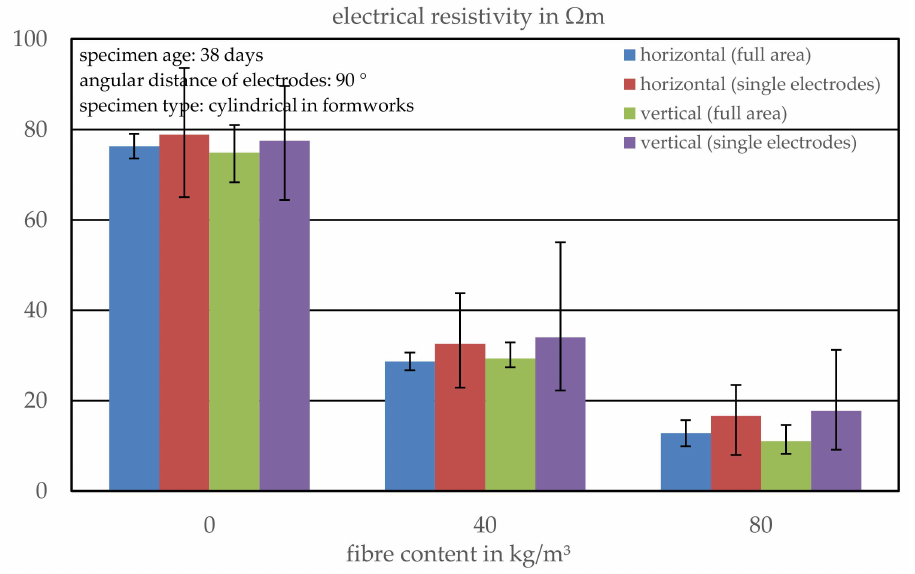
Figure A1. Electrical resistivity in different directions depending on the fibre content at a specimen age of 38 days and an electrode array with angular distances of 90 ◦ .